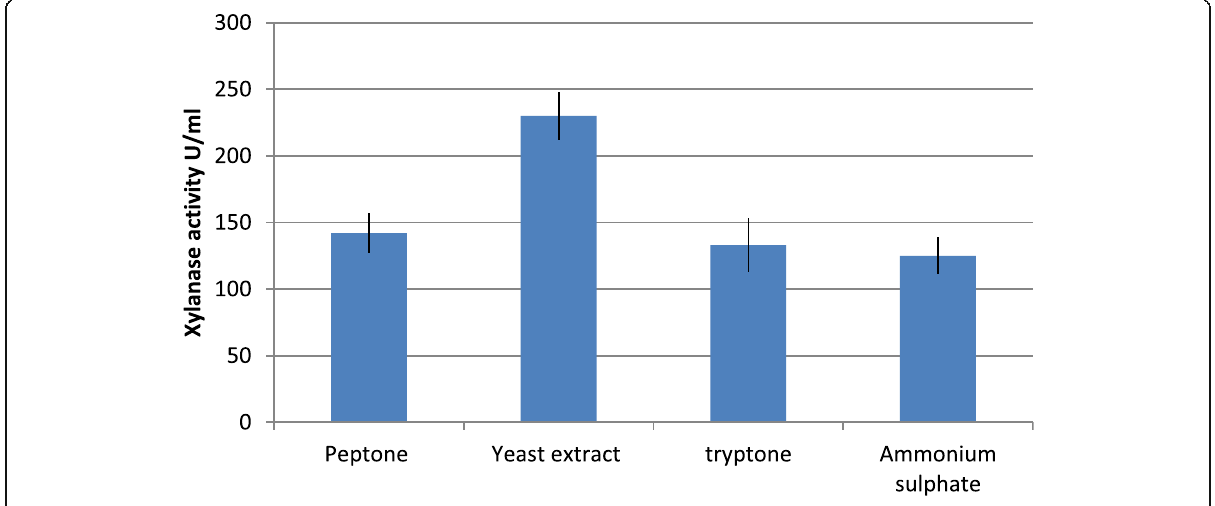
Fig. 3 Effect of different nitrogen sources on xylanase